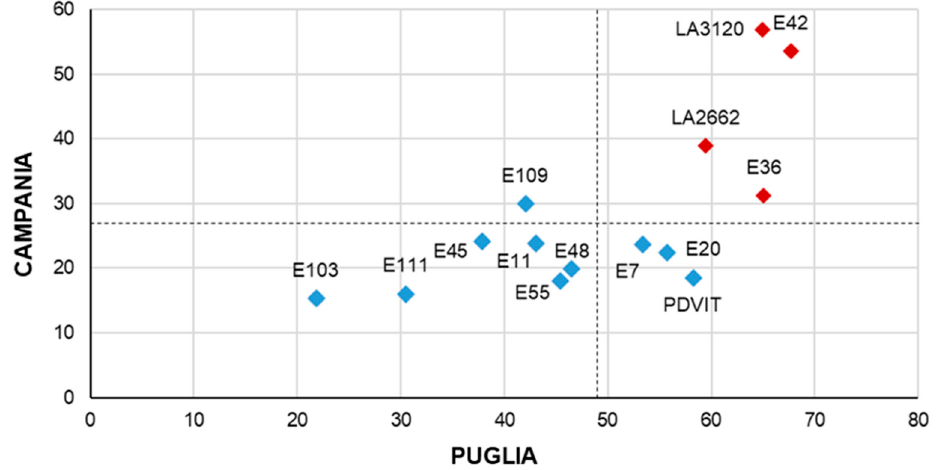
Figure 1. Scatter plot of the selection indexes (SI) calculated for 14 genotypes in the two experimental fields in Puglia ( X -axis) and in Campania ( Y -axis) pooling data recorded in the years 2016 and 2017.